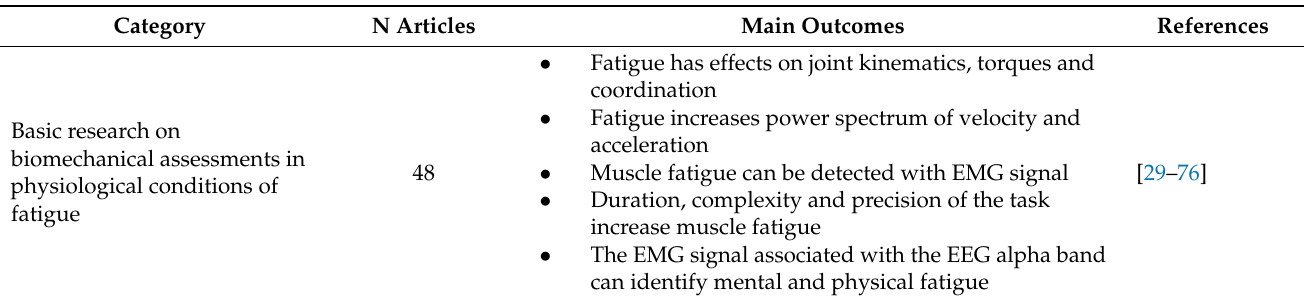
Table 1. Summary of the main findings, divided into categories related to the topic of the investiga-